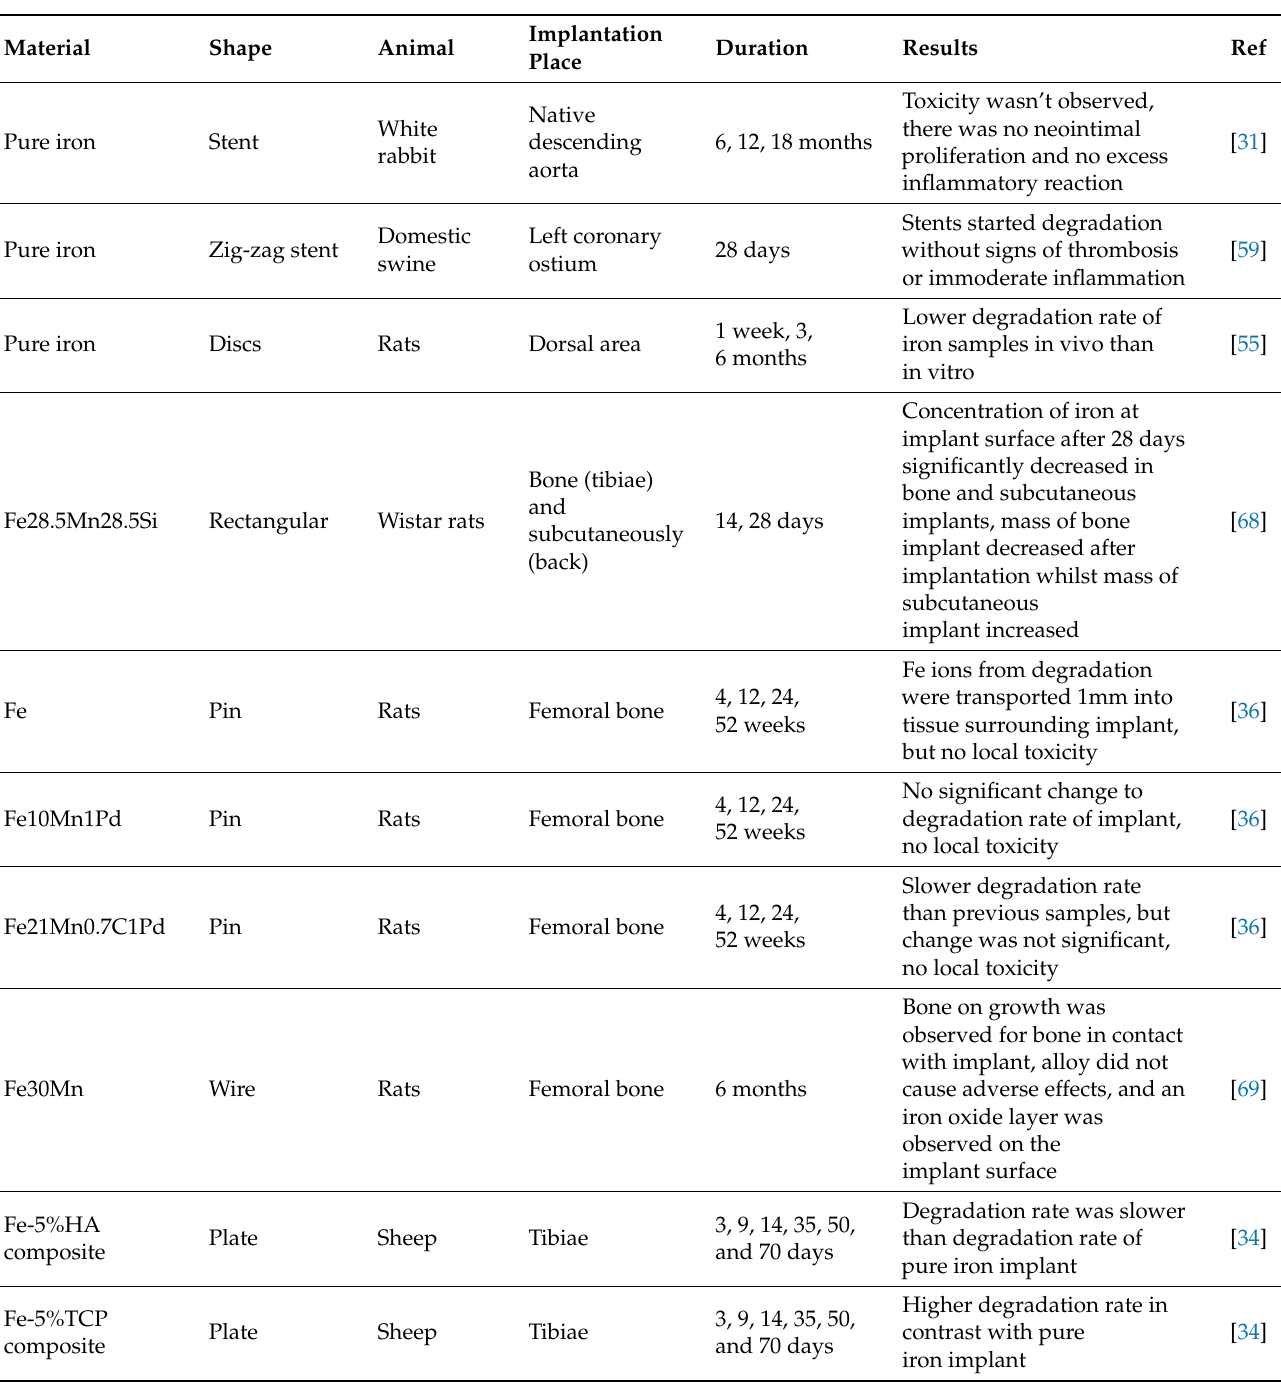
Table 2. Summary of published in vivo